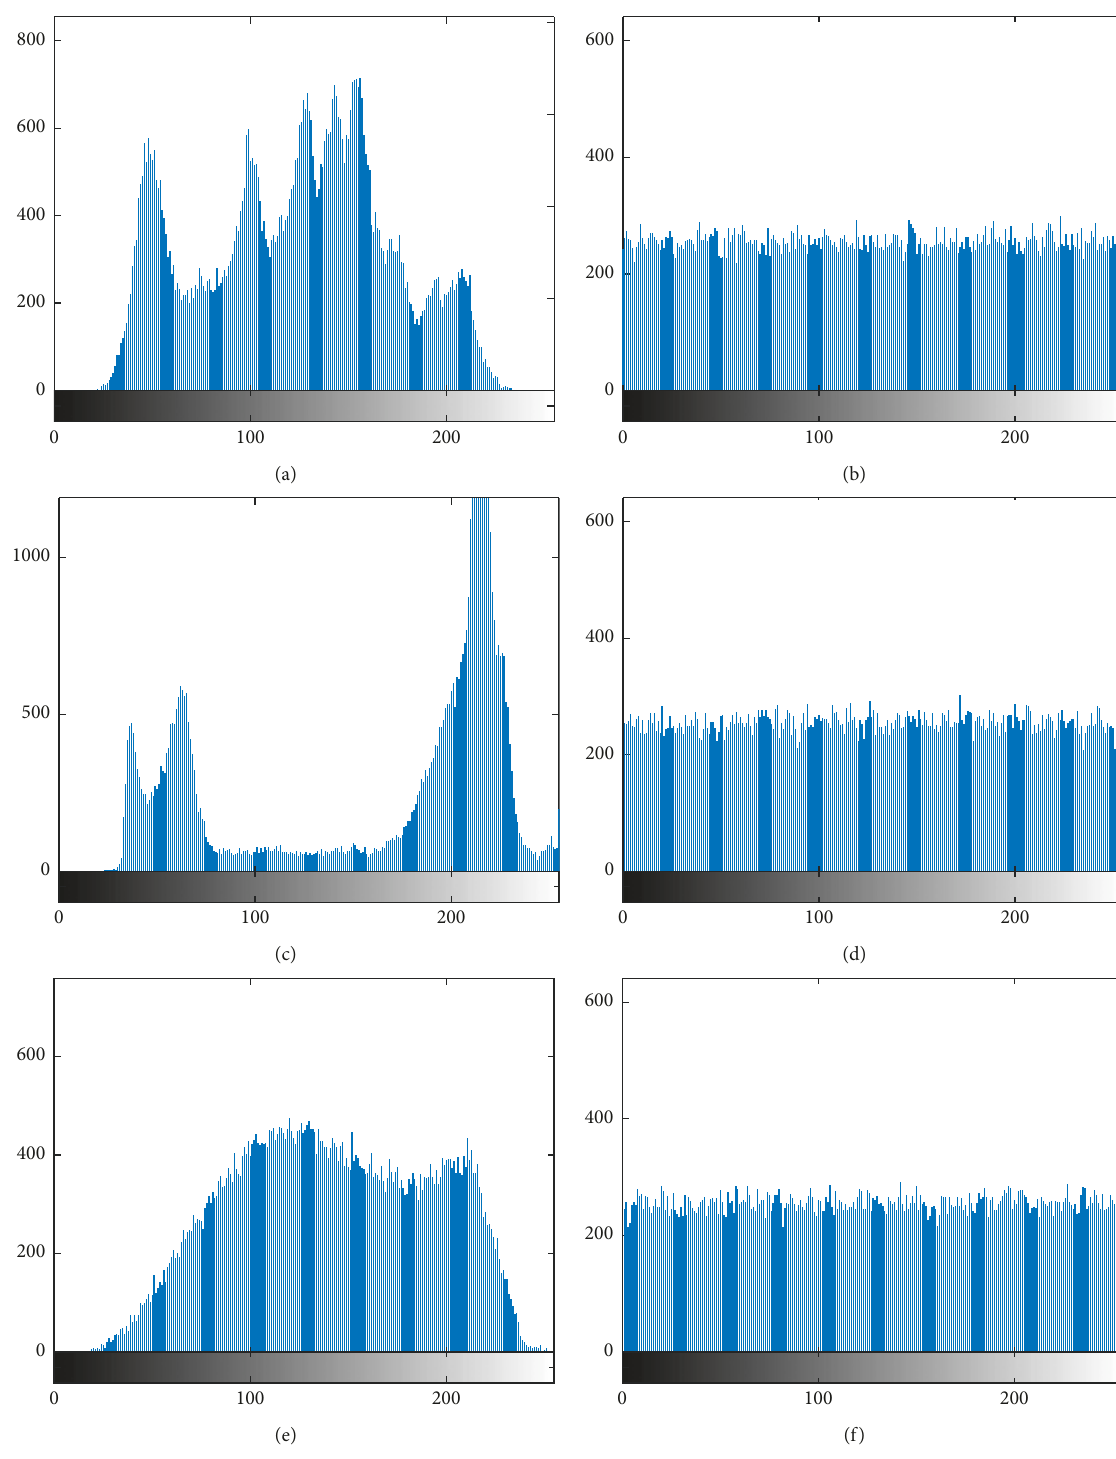
Figure 8: Histograms of original images and cipher images: (a) Lena image, (b) encrypted Lena image, (c) cameraman image, (d) encrypted cameraman image, (e) fingerprint image, and (f) encrypted fingerprint